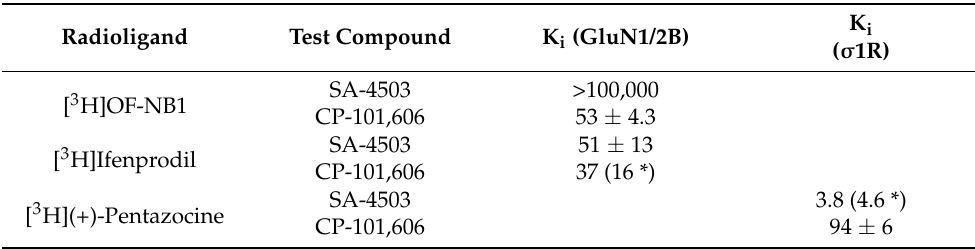
Table 1. Results of in vitro GluN1/2B and σ 1R binding affinity testing for CP-101,606 and SA-4503 in nM ± STD.